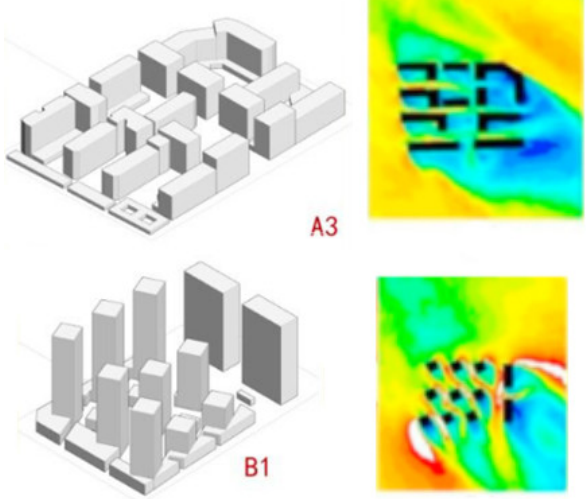
Figure 2. Urban tissues in Beijing and wind velocity contour lines (Wang et al., 2018)